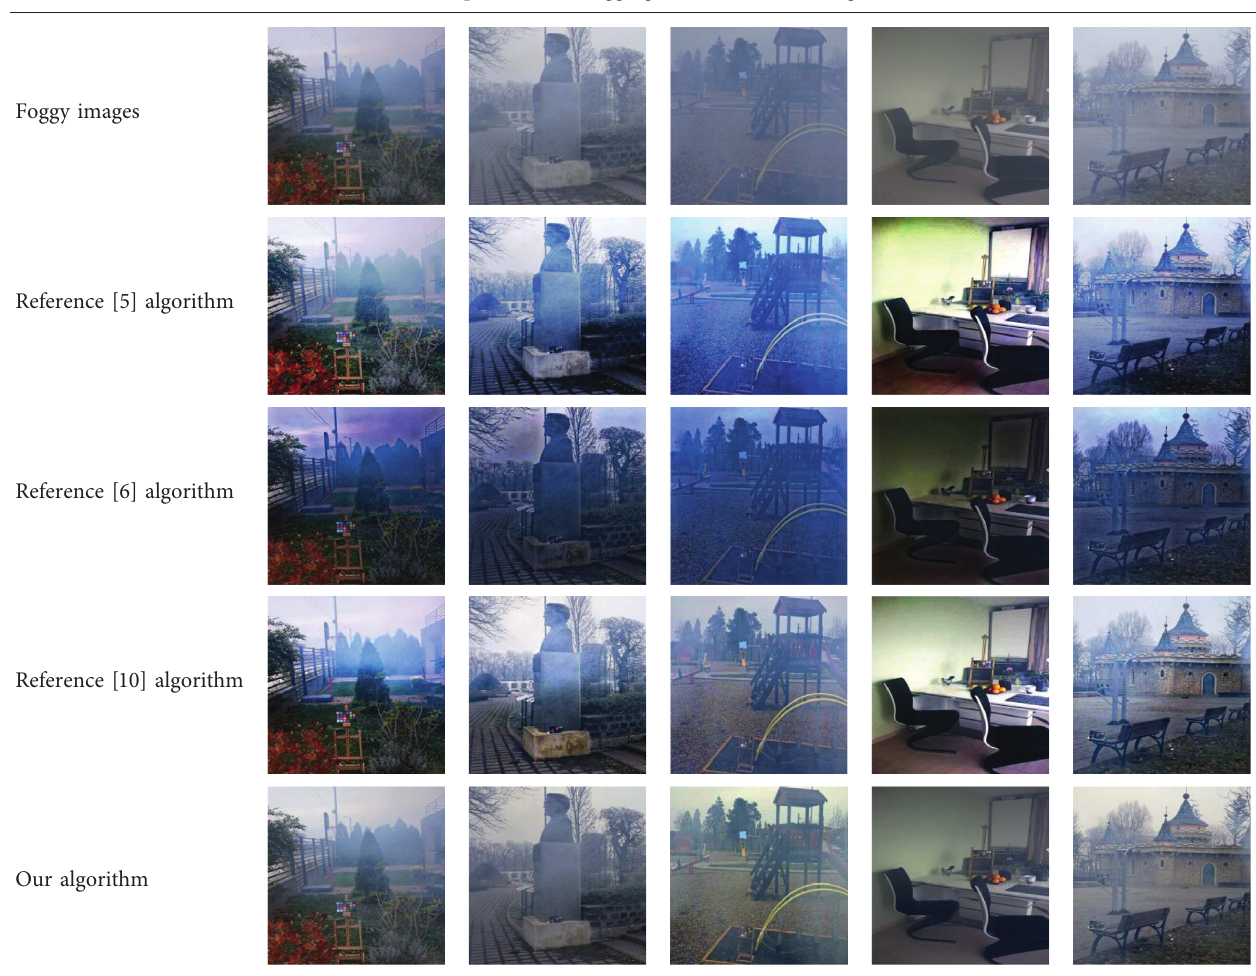
Figure 6: Some images in the training set: (a) foggy images and (b) fog-free images. Table 2: Comparison of defogging results with other